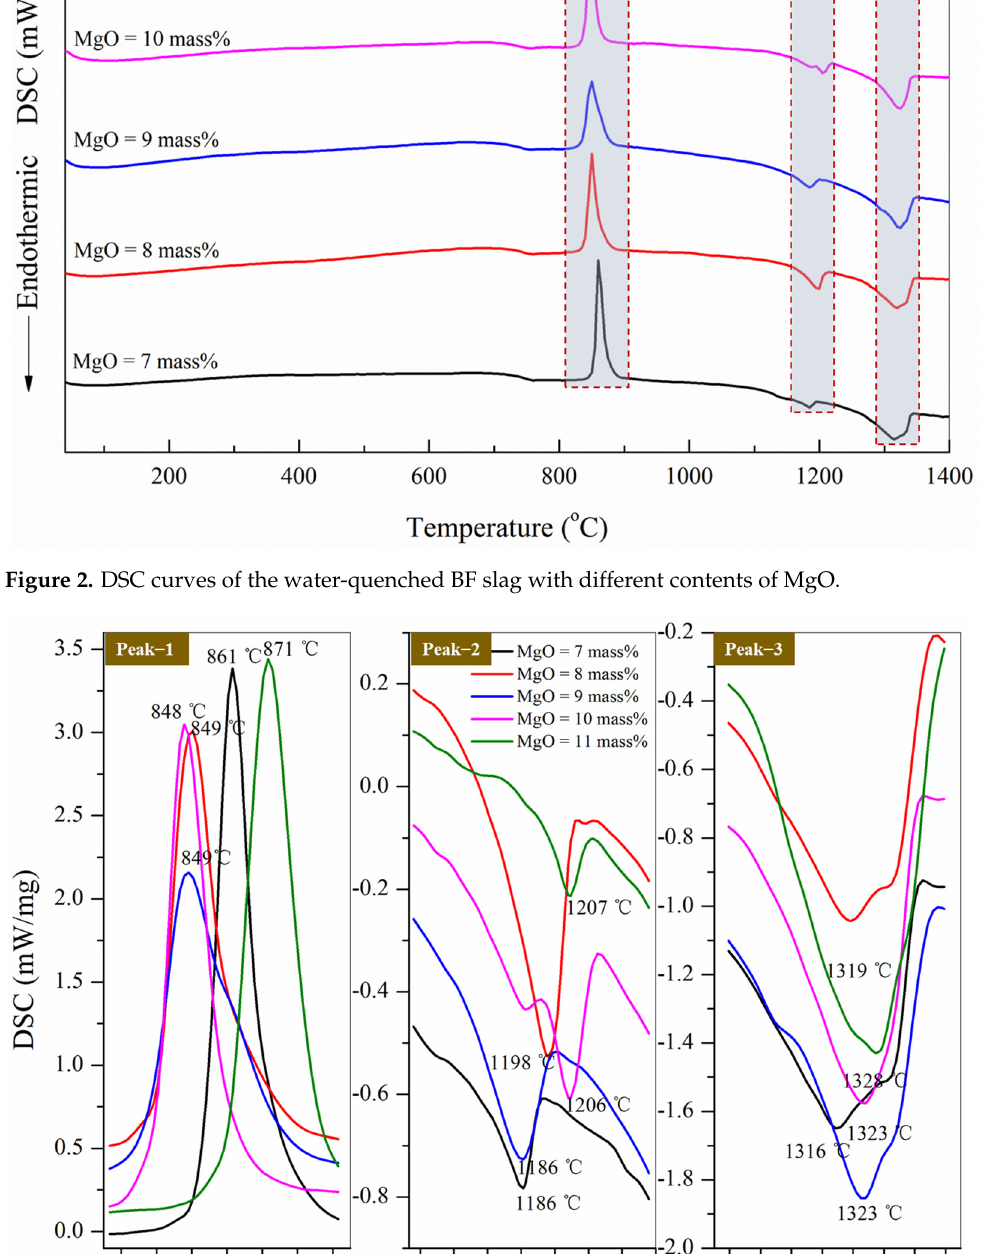
Figure 4. Change in the peaks’ temperature in the crystallization region of the BF slag with different contents of MgO. 3.2. Specific Heat Capacity and Heat Cooling Release of BF Slag with Different Contents of MgO On the basis of Equation (1), the specific heat capacity of the BF slag is calculated, and the result is shown in Figure 5. The specific heat capacity of BF slag is divided into four ranges with stable specific heat capacity by three crystallization regions during the whole heating process, namely, Range-1 (35 °C–730 °C), Range-2 (900 °C–1170 °C), Range- 3 (1220 °C–1285 °C), and Range-4 (1345 °C–1400 °C). Then, the expression of specific heat